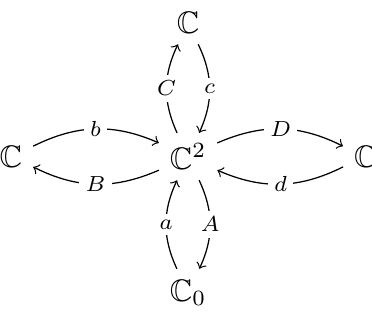
2 = 4 surface singularity x